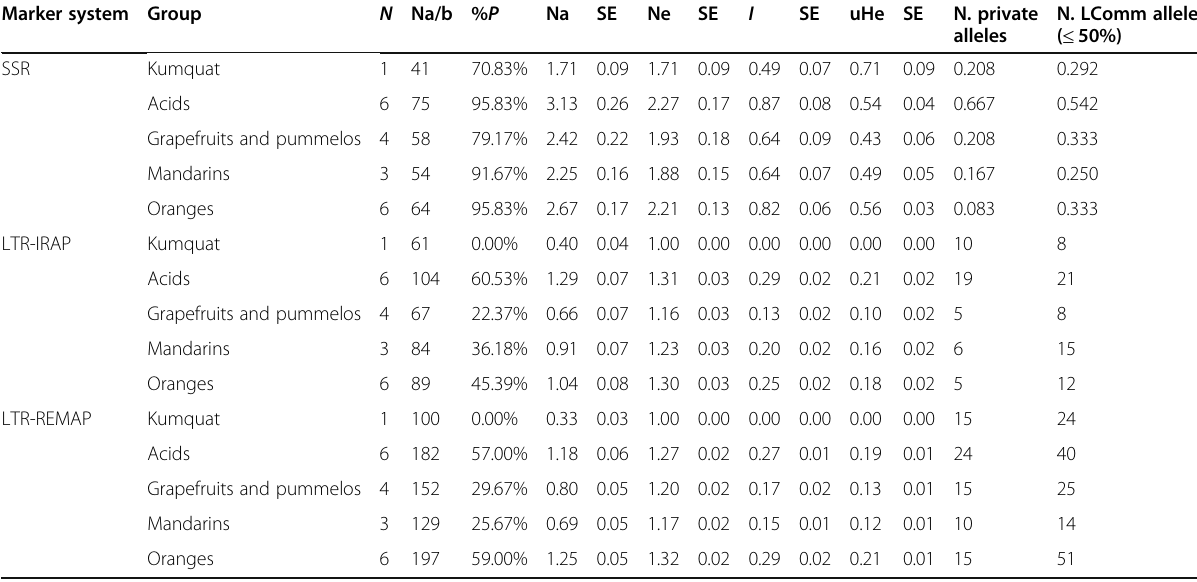
N No. of species per group, Na/b No. of alleles or bands, %P percentage of polymorphic loci, Na No. of different alleles, Ne No. of effective alleles, I Shannon ’ s Information